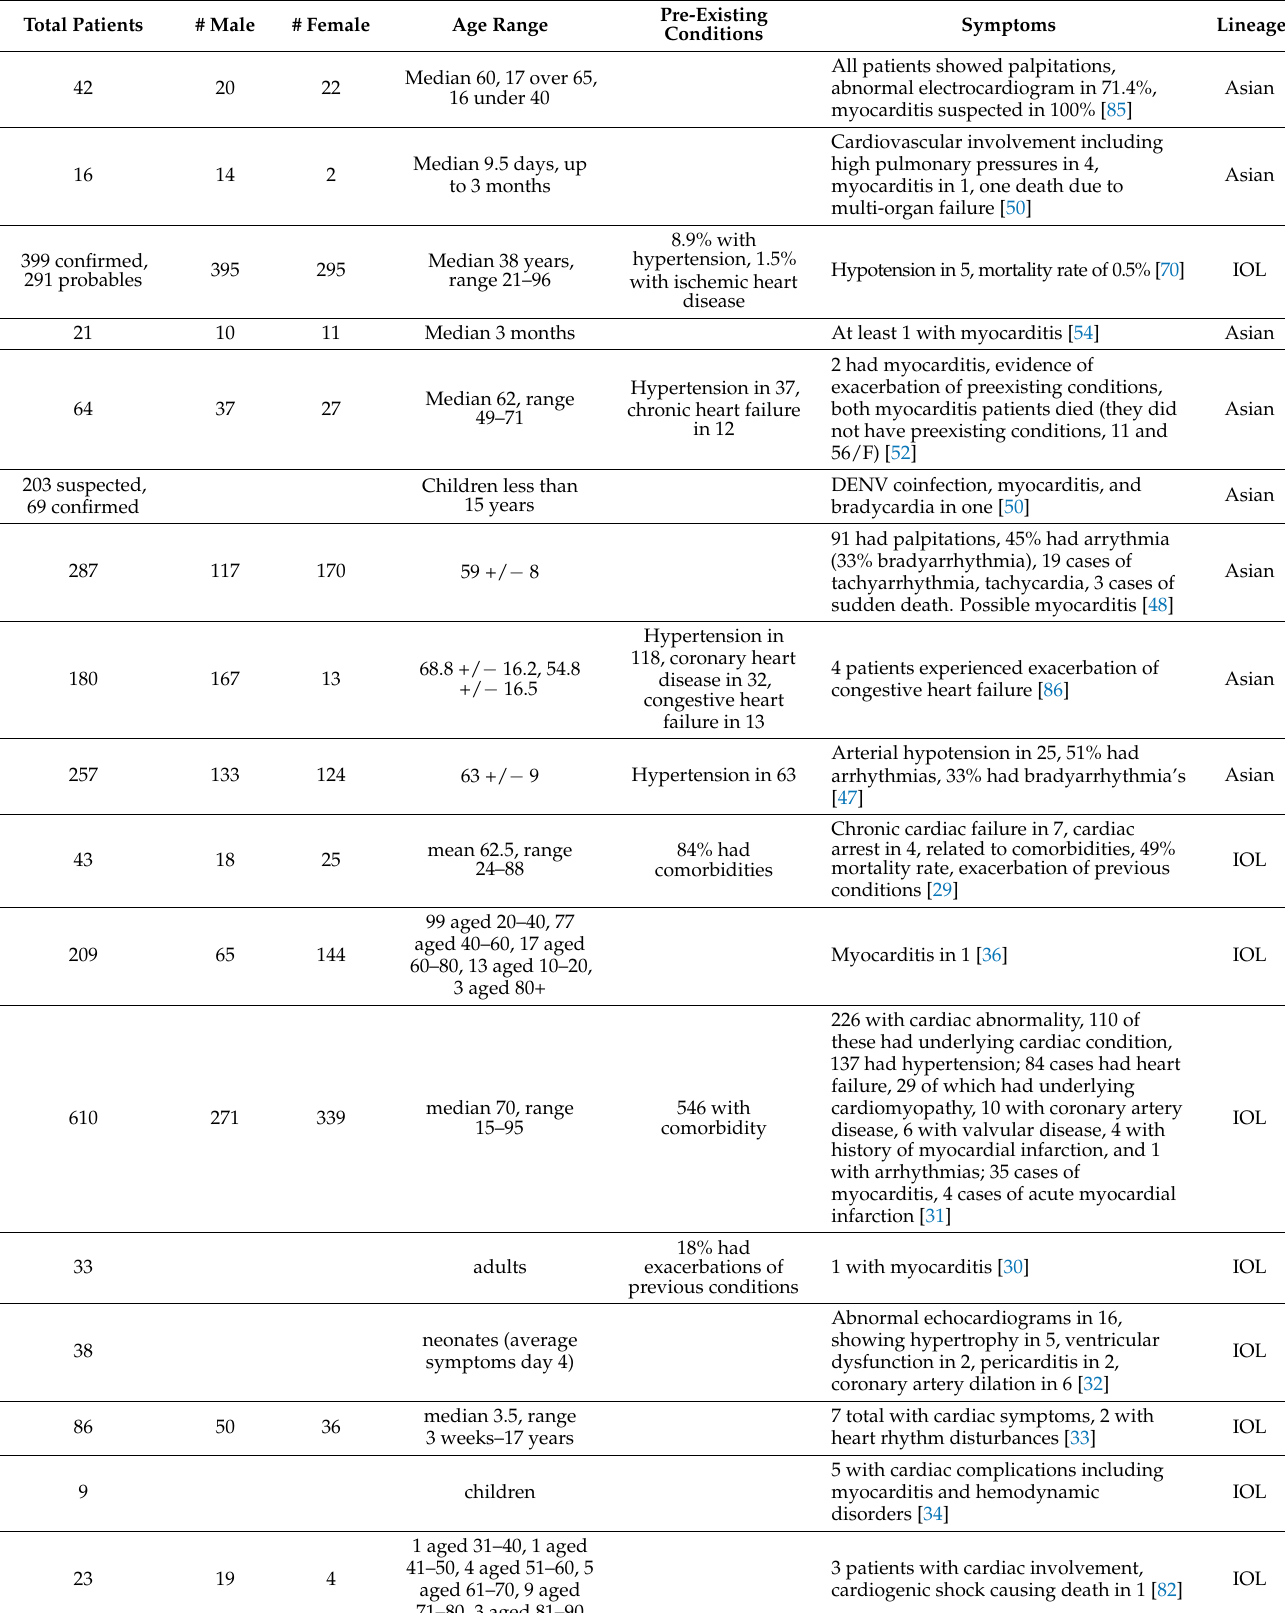
Table 3. Cardiac complications from literature that complied multiple patients. Lineage was obtained from the data when available. When unavailable, the year and location was matched to isolates in NCBI Nucleotide with Table 1 to deduce the lineage. Total